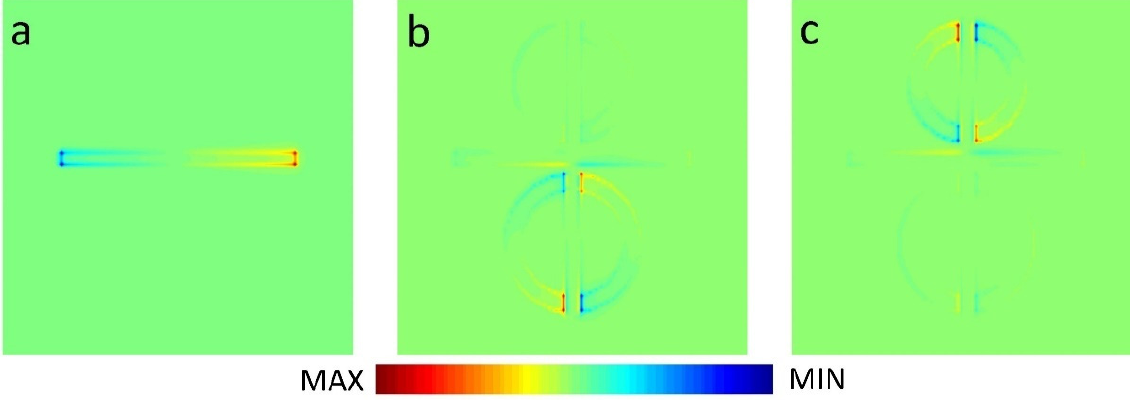
Figure 4. Charge distribution of ( a ) the CW, ( b ) the PIT metamaterials at 0.873 THz, and ( c ) the PIT metamaterials at 1.016 THz.